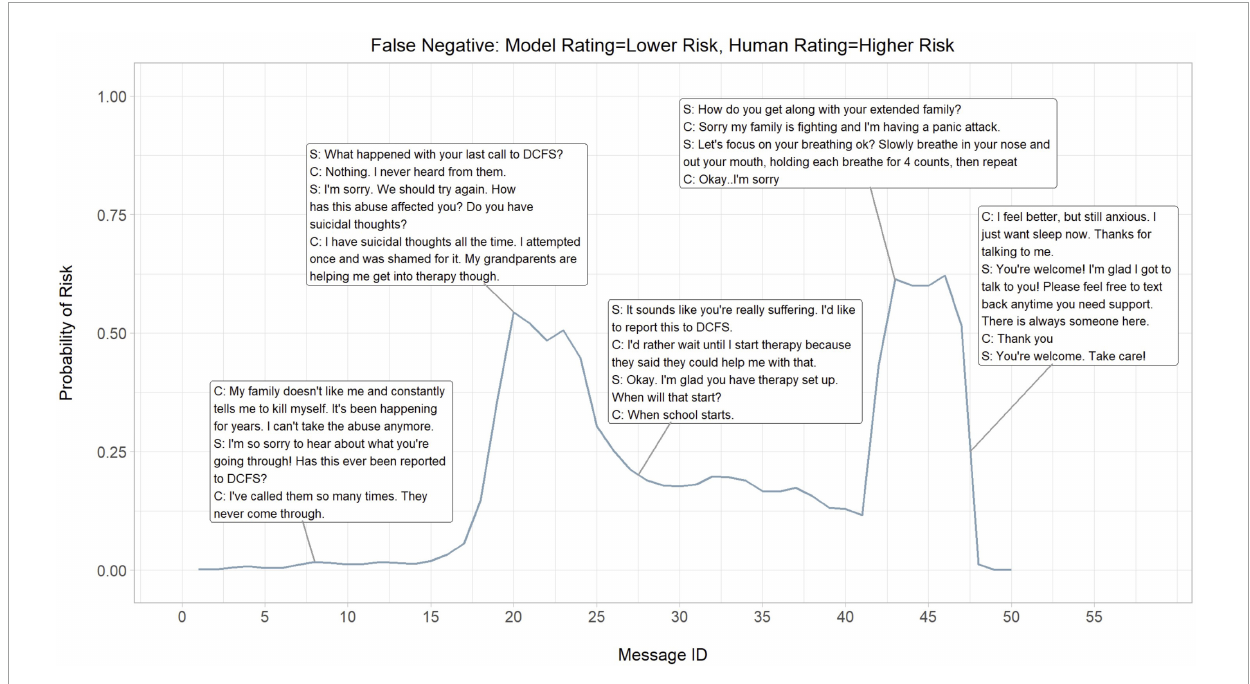
FIGURE5 Dialogue risk curves: Model rating = lower risk, Human rating = lower risk (False negative). S, SafeUT counselor; C, SafeUT client; DCFS, Division of child and Family Services. Crisis counseling encounter has been fictionalized to maintain